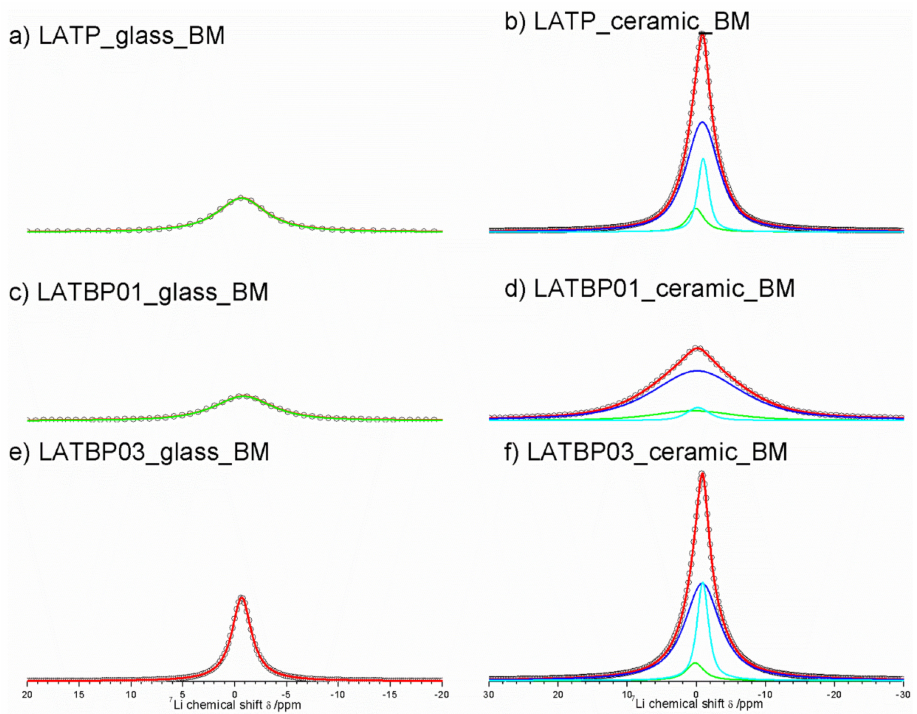
Figure 12. 1D 7 Li MAS NMR spectra of the LAT(B)P_BM series. ( a ) LATP_glass_BM ( b ) LATP_ceramic_BM ( c ) LATBP01_glass_BM ( d ) LATBP01_ceramic_BM ( e ) LATBP03_glass_BM ( f )